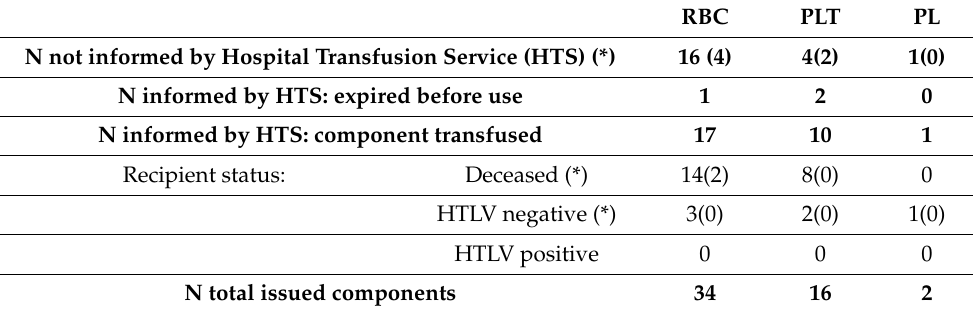
Table 5. Lookback of the 52 blood components previously obtained from undiagnosed HTLV blood